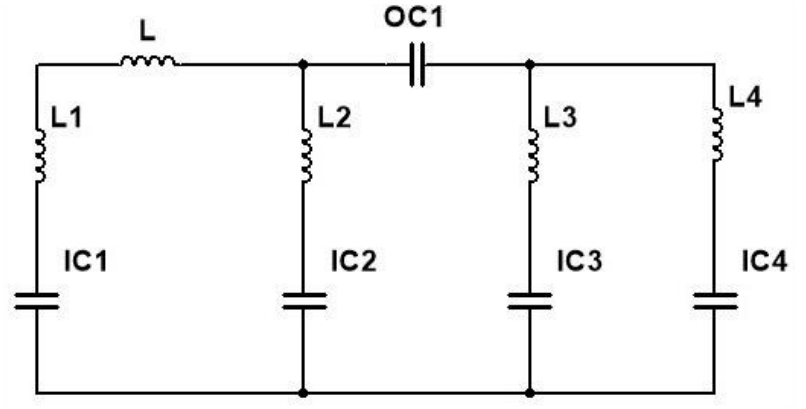
Figure 8. Equivalent circuit of the unit cell.